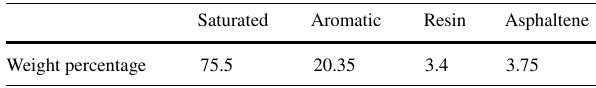
Fig. 1 Developed procedure for comprehensive asphaltene